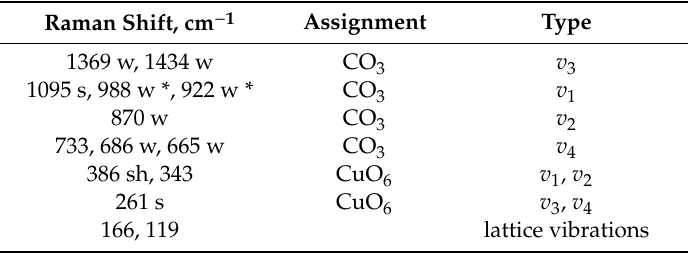
Table 6. Raman bands in the paratooite-(La) spectrum and their